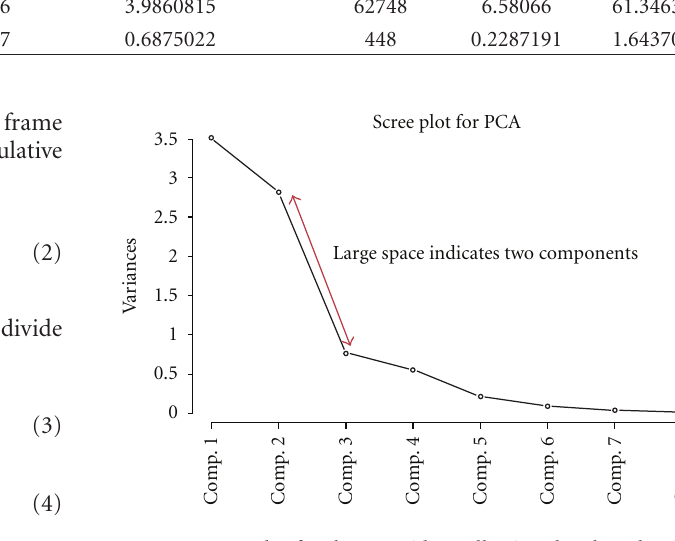
Figure 2: Scree plot for the HD video collection data based on the eight selected variables which indicates two principal